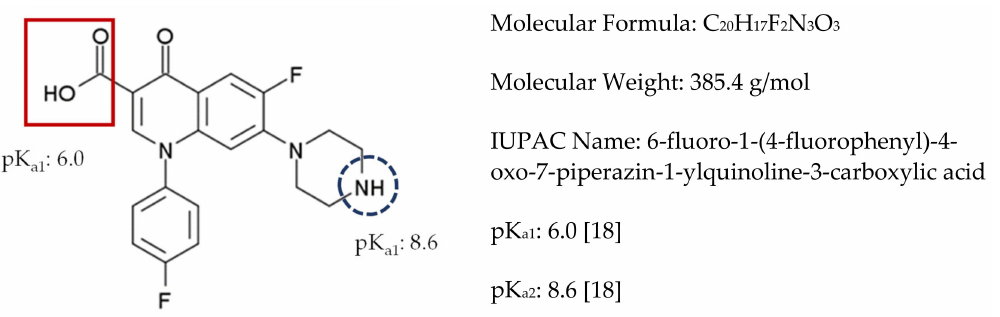
Figure 1. Chemical structure of SARA together with the physicochemical relevant